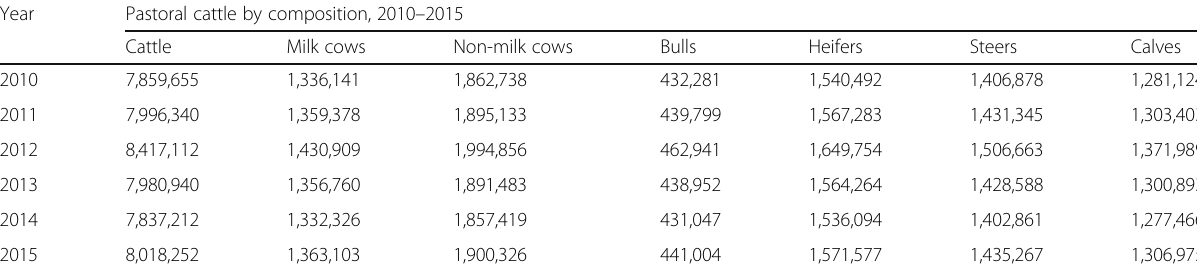
Table 2 Pastoral cattle herd